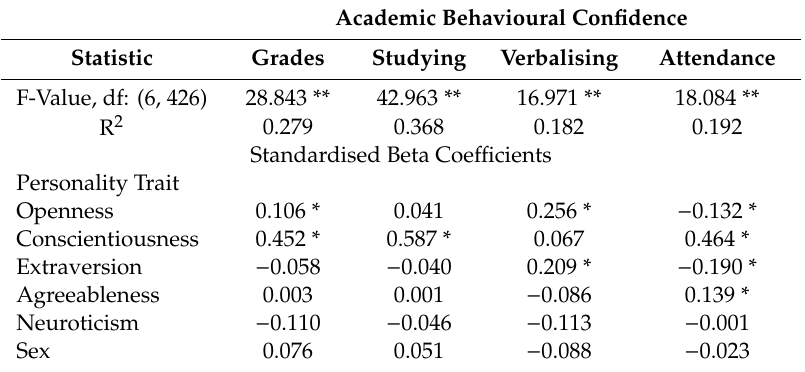
Table 7. Analysis of sex and personality on academic confidence by